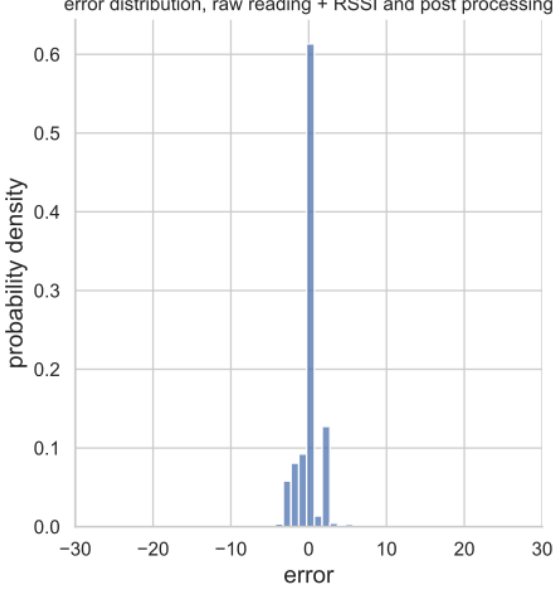
Figure 12. Histogram of estimation errors for the augmented sensor (i.e., the one taking as input both raw readings and RSSIs) on the test set after